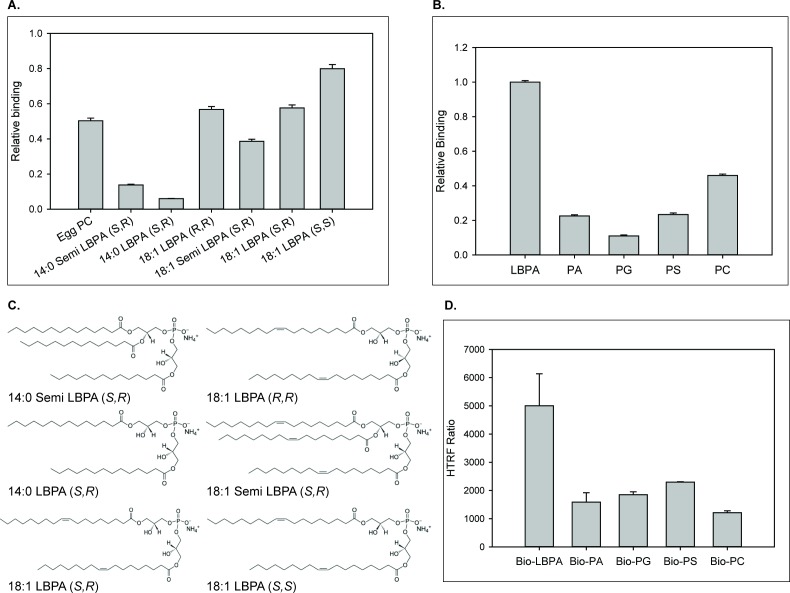
NPC2 binding to LBPA and other phospholipids.(A) WT NPC2 protein was incubated with strips (Snoopers) containing LBPA isomers. LBPA-bound protein was detected with anti-c-myc antibody as described under Methods, and degree of binding ± SE (n = 3) is represented by the integrated density of the blots. (B) 500 pmol of various membrane phospholipids were spotted onto nitrocellulose strips and probed with WT NPC2-myc-his protein as described under Methods. Relative binding of WT NPC2 ± SE (n = 5) is shown, represented by signal intensity detected with the LI-COR system. (C) Structures of the LBPA isomers. (D) 75 nM of WT NPC2 protein was incubated with 1 μM of the indicated biotin-C12-ether phospholipid, streptavidin-d2 conjugate and europium cryptate–labeled monoclonal anti-histidine antibody in detection buffer, as described in Methods. FRET signal between europium cryptate and streptavidin was detected with a HTRF capable Envision plate reader (λex = 320 nm, λem = 615 and 665 nm; 100 μs delay time; n = 3).